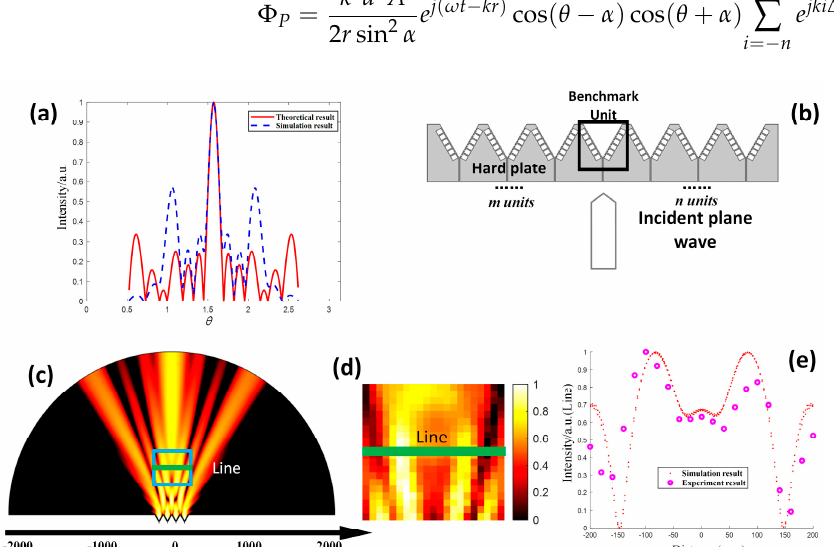
Figure 6. ( a ) Comparison of theoretical and simulated quadrupole linear arrays for | Z s / ρ 0 c 0 |≈ 0. ( b ) Simulated sound pressure for | Z s / ρ 0 c 0 | ≈ 0. ( c ) Schematic of the quadrupole linear array. ( d ) Experimental sound pressure for α = 30 ◦ , ∆ l / λ = 2, and | Z s / ρ 0 c 0 |≈ 0. ( e ) Comparison between the experimental and simulated results at “Line”.